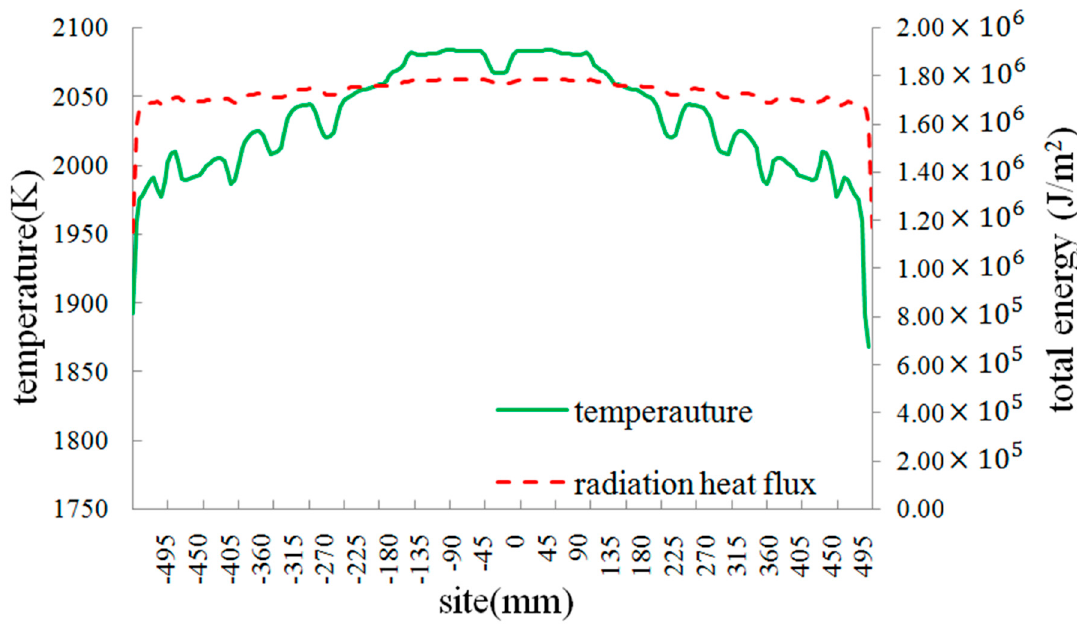
Figure 8. Radiation heat flux and temperature distribution on the bottom surface.